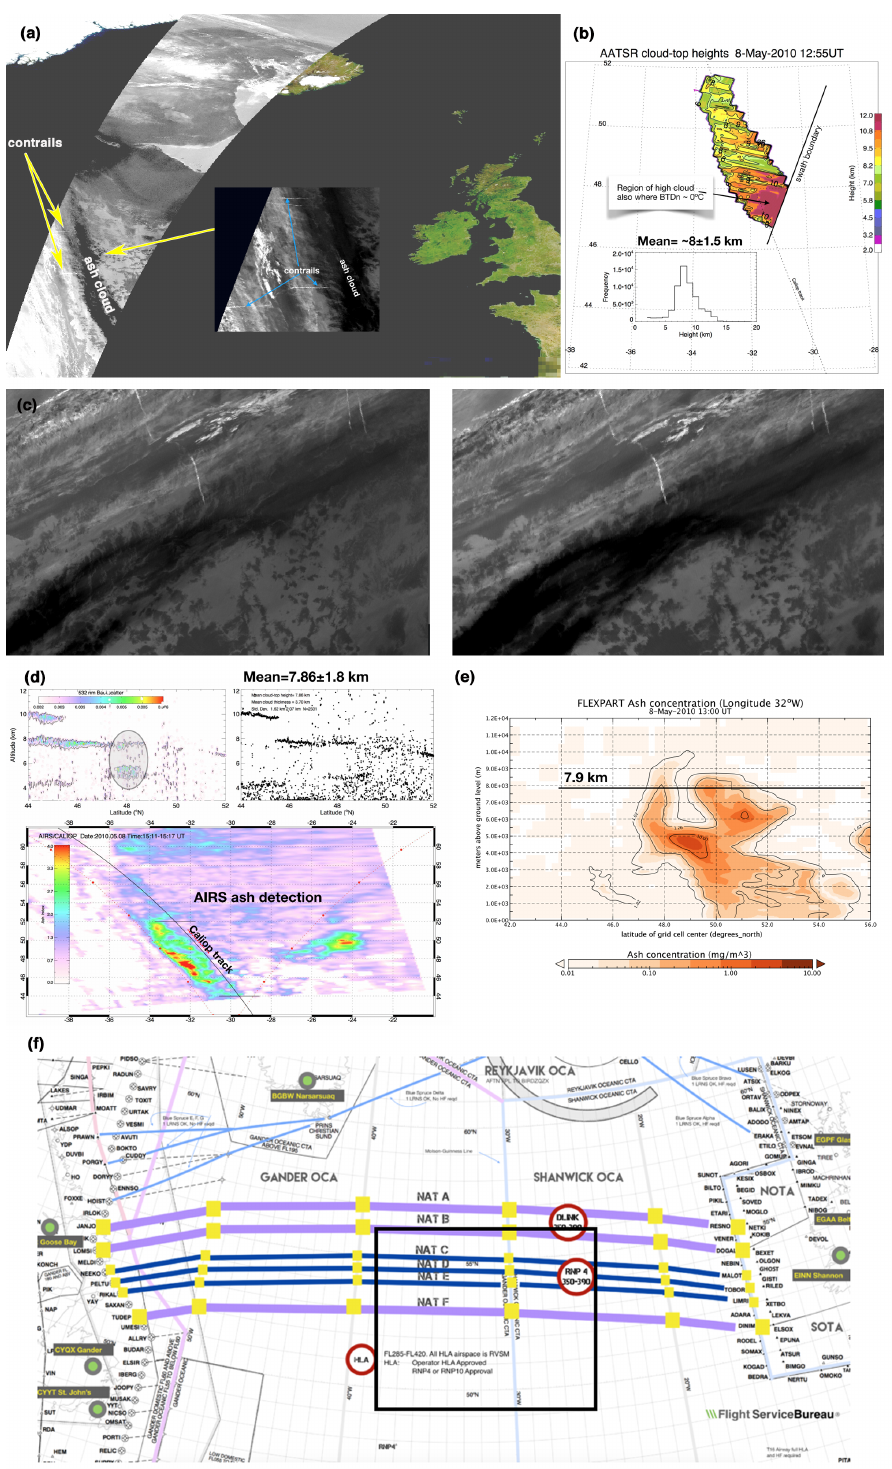
Figure 13. AATSR height retrieval. ( a ) BTD image showing location of the AATSR orbit path, ash clouds and contrails. ( b ) AATSR quantitative height retrieval. ( c ) AATSR stereo pair using the 1.6 µ m channels. ( d ) Caliop validation data and AIRS ash detection showing the approximate path of the Caliop sub-satellite point. ( e ) FLEXPART modelling for the same ash cloud. ( f ) Location of the north Atlantic tracks (NAT). These are typically at altitudes of 29,000–41,000 ft ( ∼ 8.8–12.5